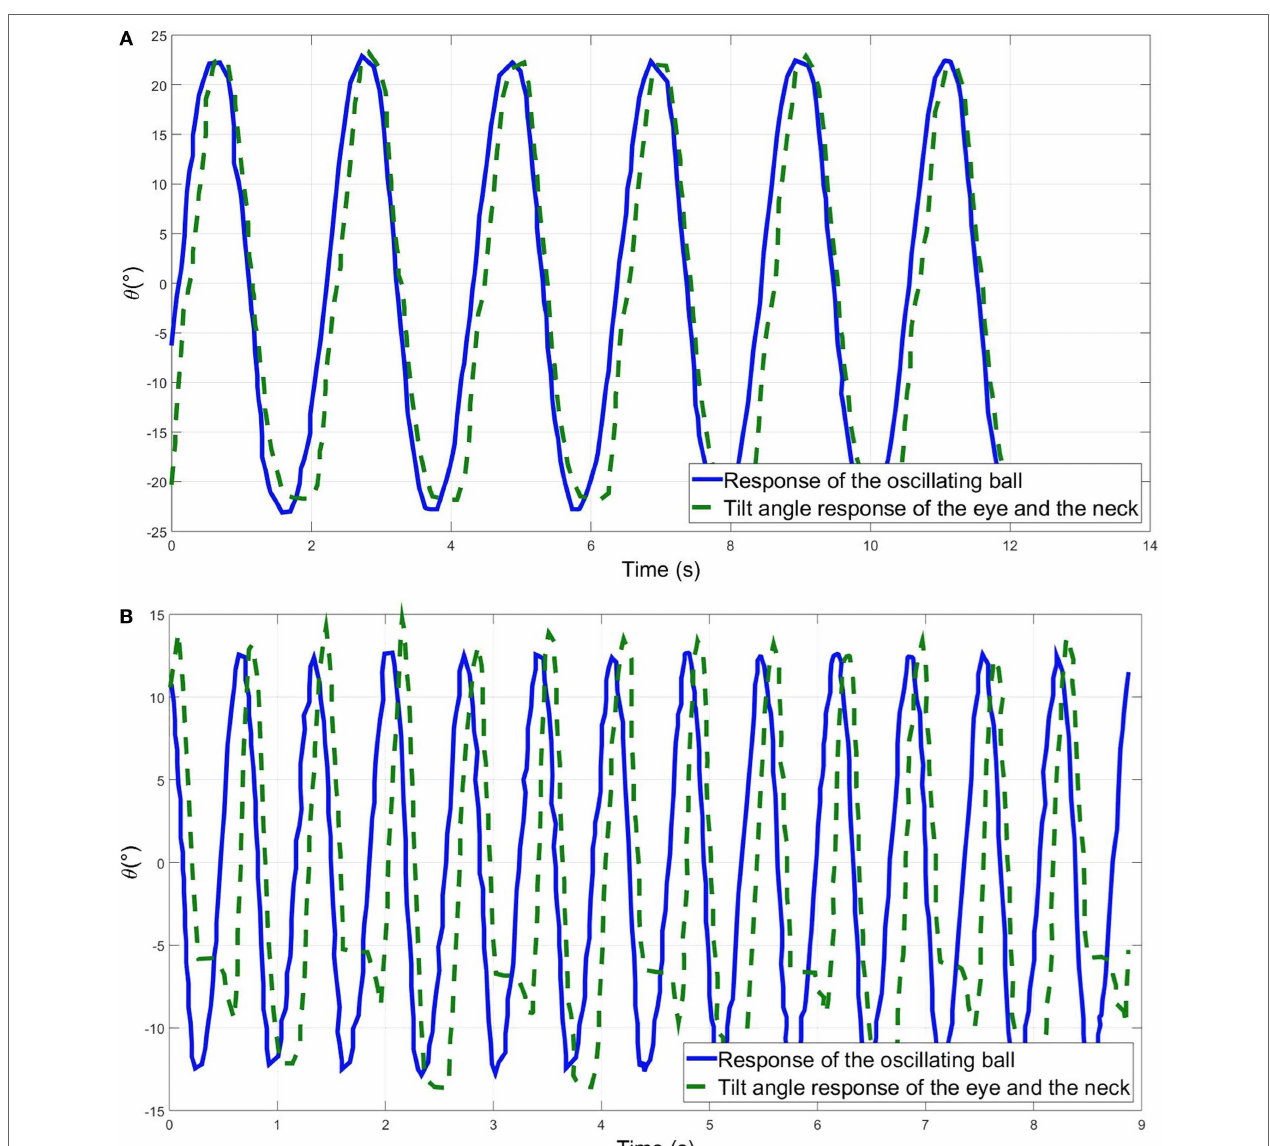
FIGURE 15 | Yaw rotation of the eye and neck of the robotic head while tracking an oscillating ball at: (A) 0.5Hz and (B) 1.5Hz